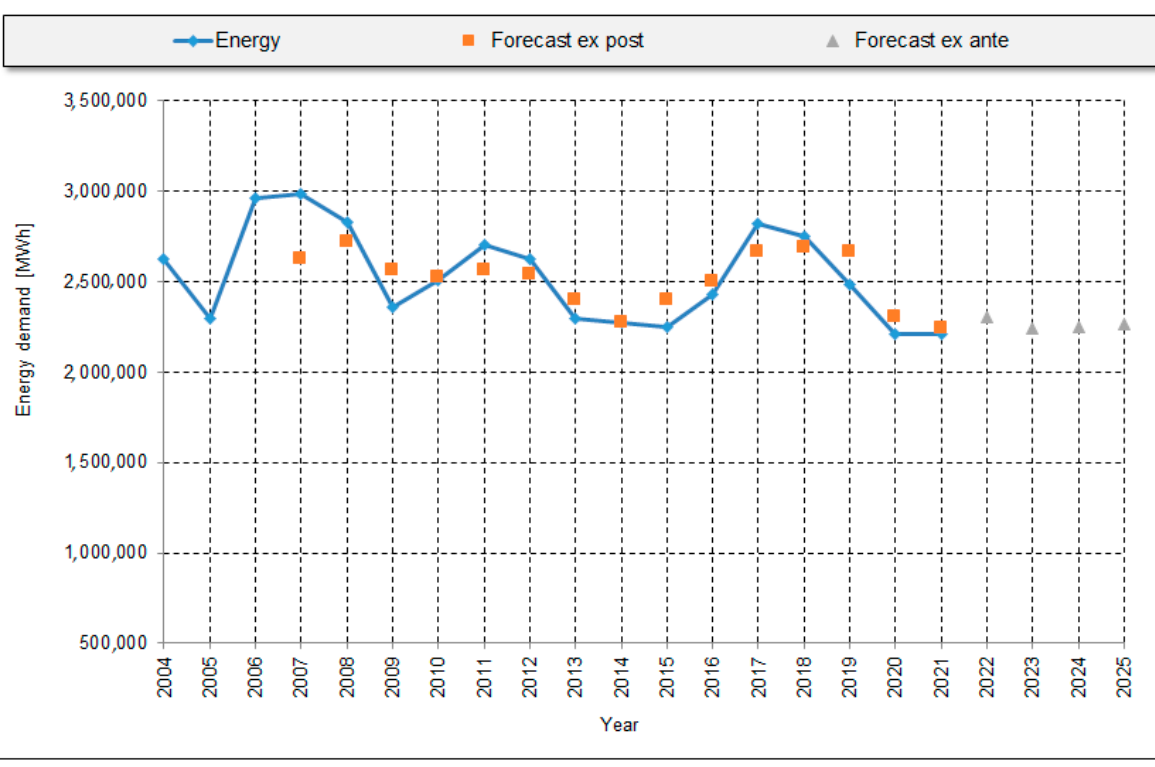
Figure 16. Forecasts of energy demand in steel industry in Poland.